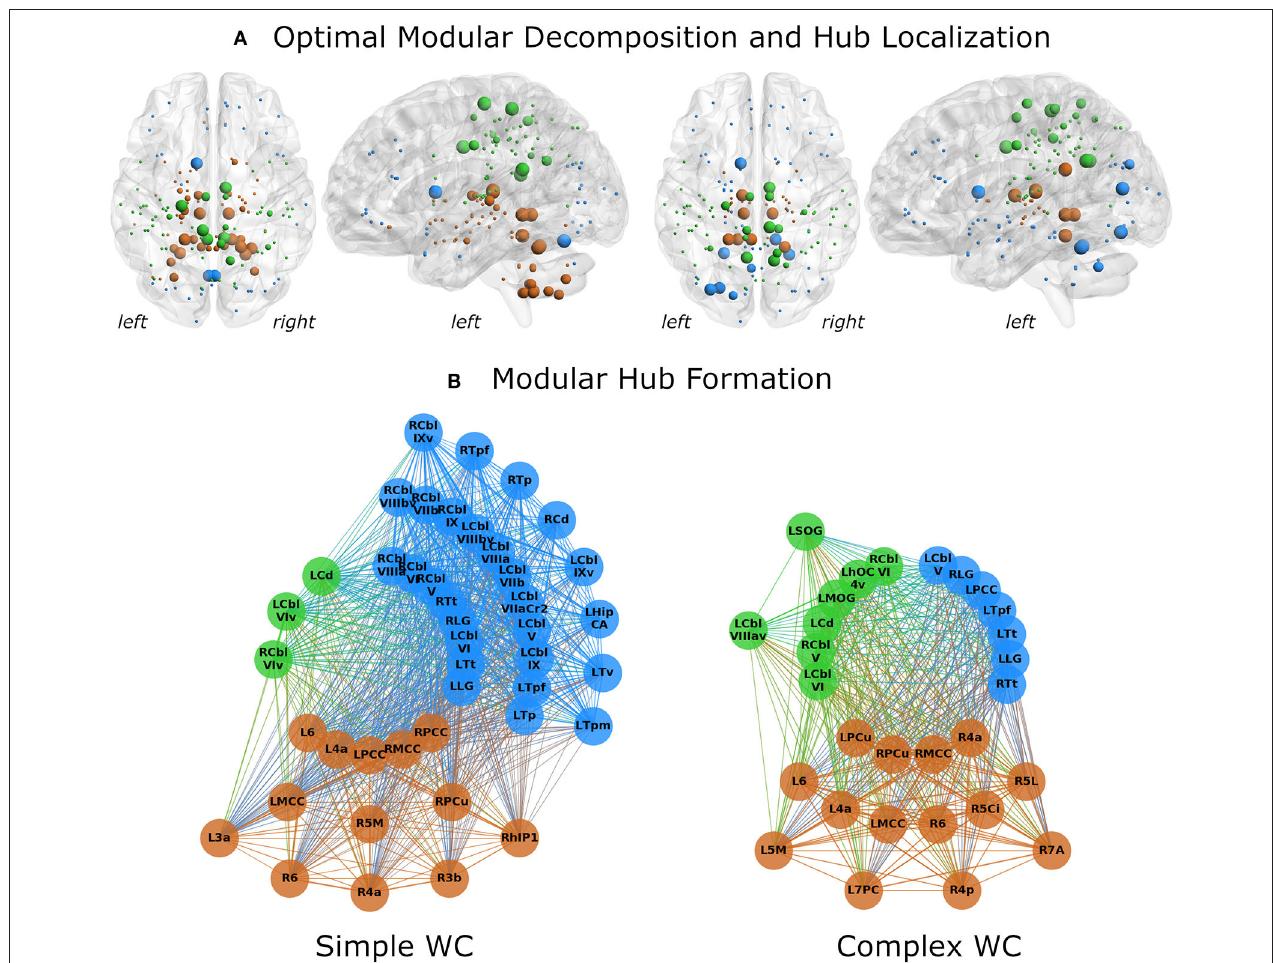
FIGURE 3 | Network analysis results for simple (left) and complex (right) writer’s cramp subgroups. (A) The optimal modular decomposition is shown by colored nodes in a 3D glass brain. Both groups had three modules: a fronto-occipital module (blue), a parietal module (green), and a subcortical module (brown). The subcortical module was larger in the SWC group, spreading into the cerebellum. The size of each node indicates its hub status, from largest to smallest: connector hubs, provincial hubs, high influence nodes, other nodes. Hub distribution in both groups was mostly restricted to the posterior part of the brain. (B) Hubs per module. All regions that were either hubs or high influence nodes are presented as colored nodes. Color illustrated module affiliation (as in A ). Nodes are arranged in three circles according to their hub status: connector hubs (innermost circle), provincial hubs (intermediate circle) and high influence nodes (outer circle). Both groups recruited nearly the same number of connector hubs, but the SWC group’s network contained more provincial hubs and high influence nodes. 3a/3b/6, BAs 3a/3b/6; 4a/4p, anterior/posterior part of BA 4; 5Ci/5L/5M, subdivisions of BA 5; 7A/7PC, subdivisions of BA 7; Cbl V/VI/VIv/VIIa crus II/VIIb/VIIIa/VIIIav/VIIIbv/IX/IXv, cerebellar lobules V/VI/VI vermis/VIIa crus II/VIIb/VIIIa/VIIIa vermis/VIIIb vermis/IX/IX vermis; Cd, caudate nucleus; HipCA, subdivision of the hippocampus; hlP1, intraparietal sulcus subdivision hlP1; hOC4v, ventral part of area hOC4; LG, lingual gyrus; MCC/PCC, middle/posterior cingulate cortex; MOG, middle occipital gyrus; PCu, precuneus; SOG, superior orbital gyrus; Tp/Tpf/Tpm/Tt/Tv, parietal/prefrontal/premotor/temporal/visual subdivision of the thalamus; L, left; R,